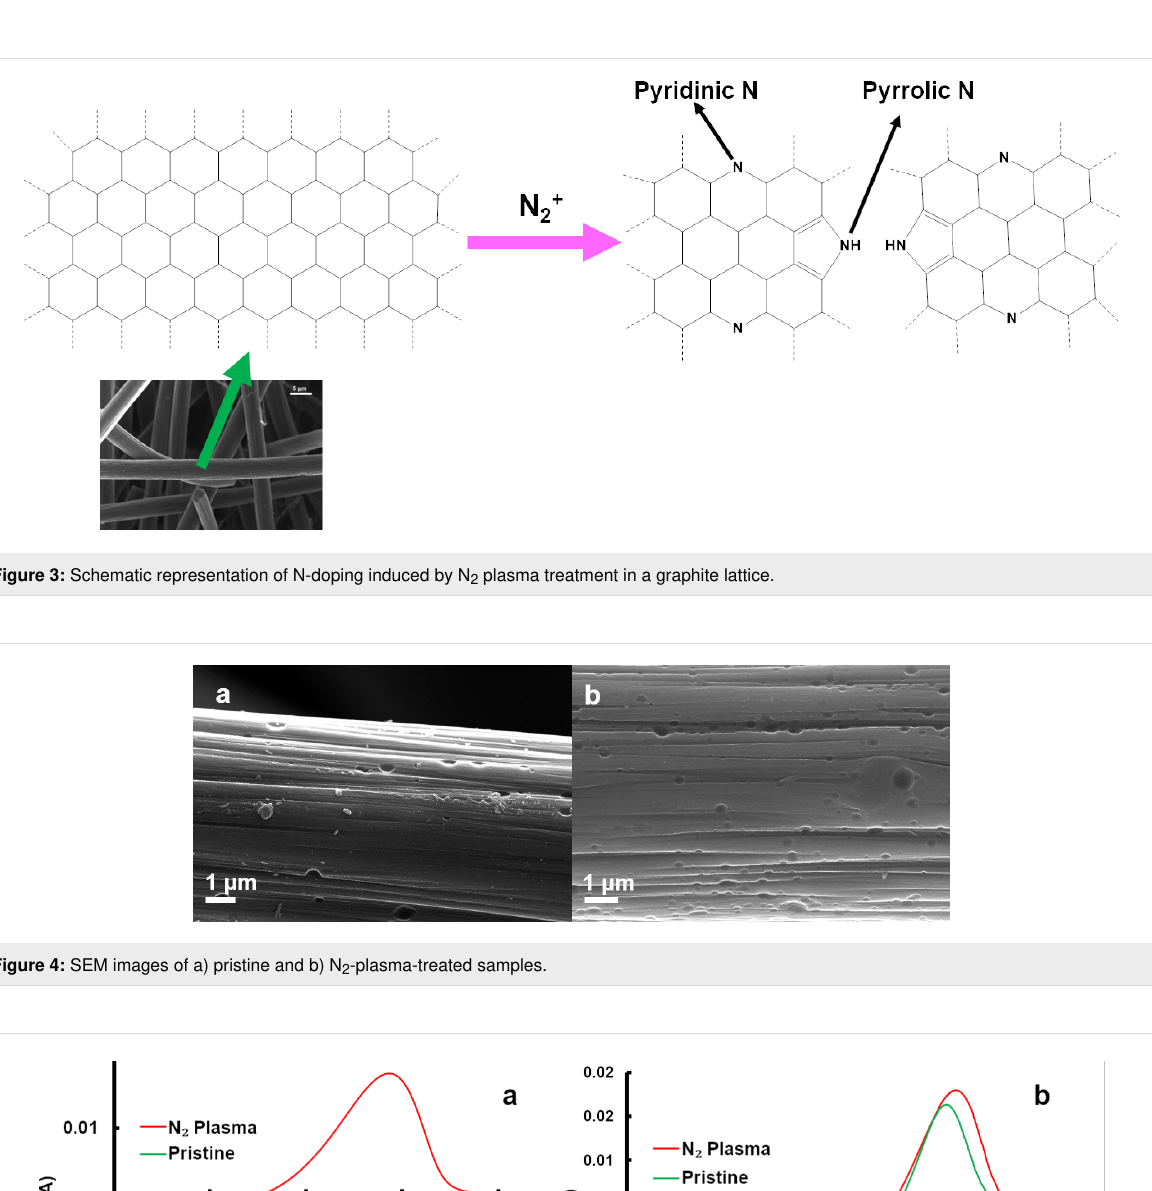
process. As a result of this process, more electrochemically active sites (edge sites) are available for the V 3+ /V 2+ redox reaction. As far as the V 5+ /V 4+ redox reaction (i.e., the positive redox reaction) is concerned, both pristine, as well as N 2 -plasma-treated carbon felts showed electrochemical activity. Compared to pristine carbon felt the N 2 -plasma-treated